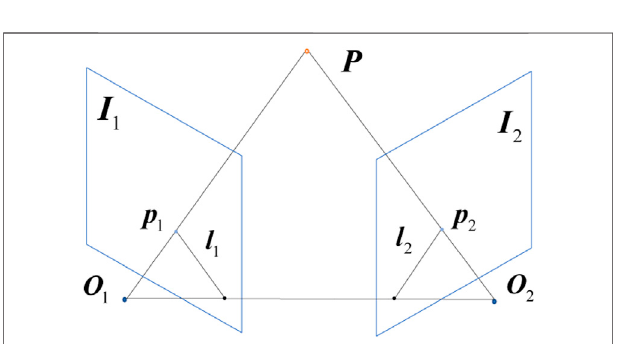
FIGURE 4 | The demonstration of epipolar geometry constraint.